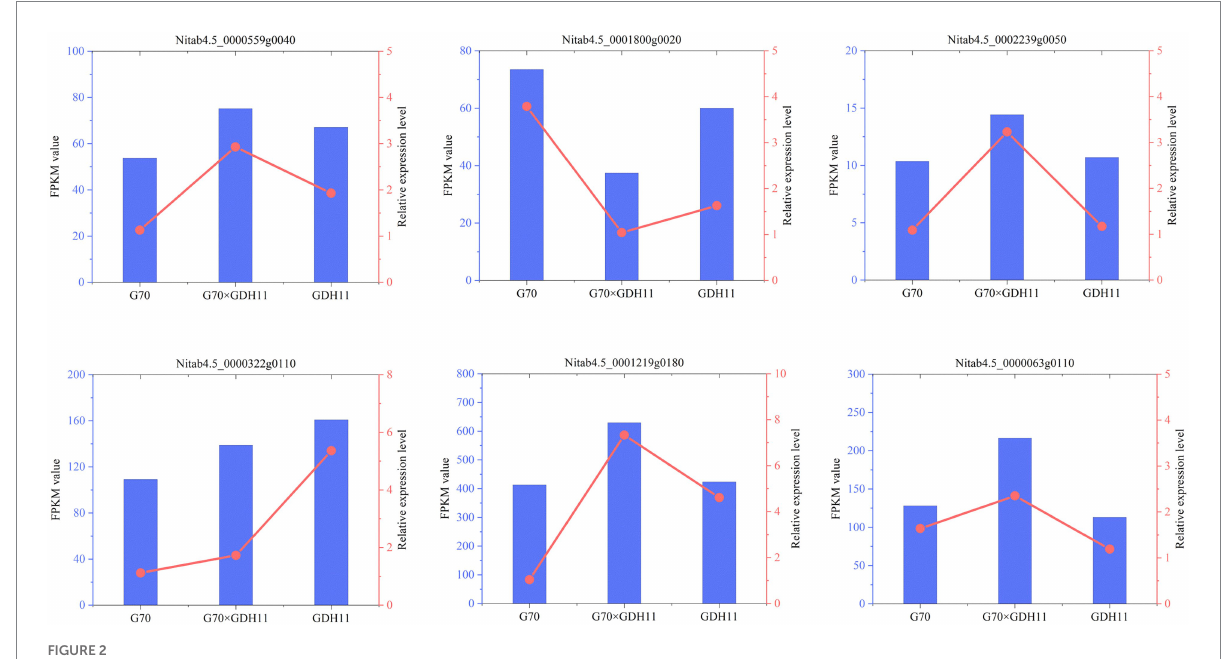
FIGURE 2 Validation of transcriptomics data through qRT-PCR